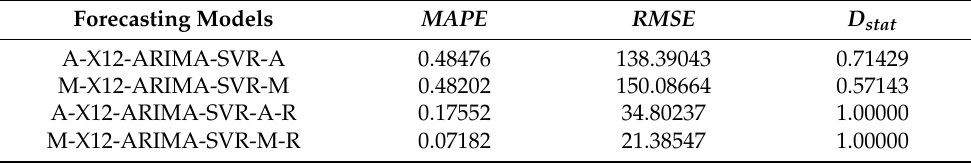
Table 4. The prediction performance of gasoline consumption in Henan.